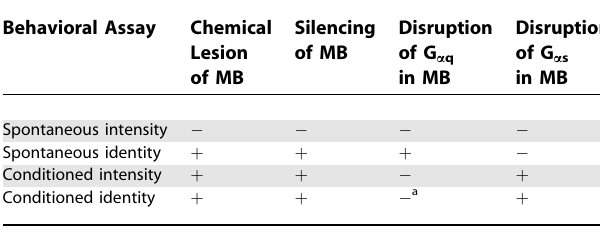
Table 1. Effects of Four Experimental Manipulations of MB Function on Four Behavioral Assays of Odor Discrimination